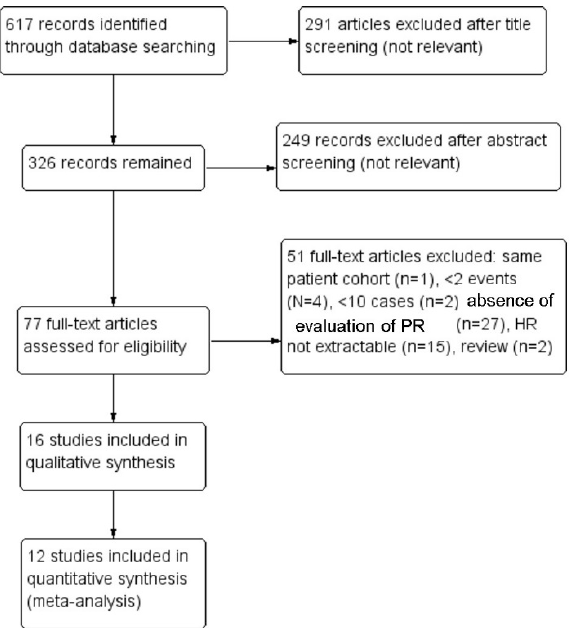
Figure 1. Flow diagram of studies identified in the systematic review (Preferred Reporting Item for Systematic Reviews and Meta-analyses (PRISMA) template).PR — pathological response.